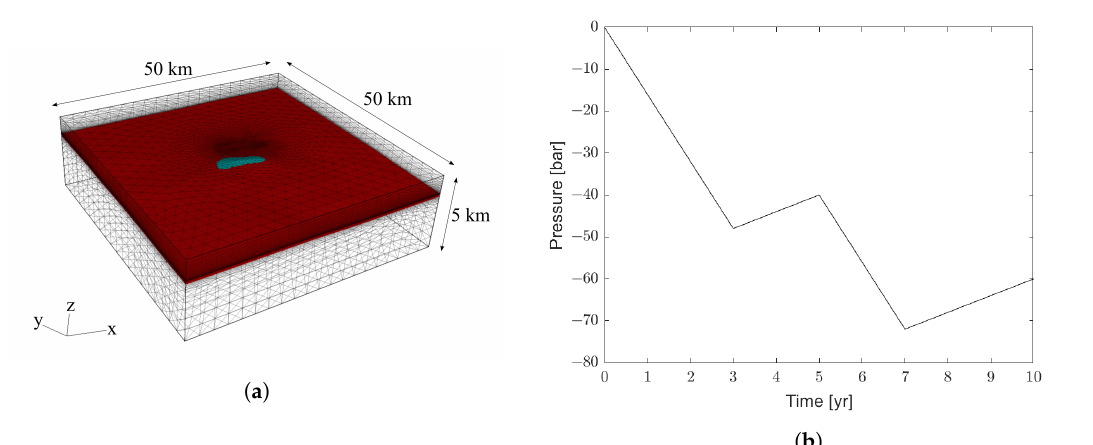
Figure 1. ( a ) View of the three-dimensional finite element grid of the regional geomechanical model. The hydrocarbon reservoir is blue, while the connected aquifer is red. The vertical axis is exaggerated by a factor 3. ( b ) Average pore pressure variation in time within the